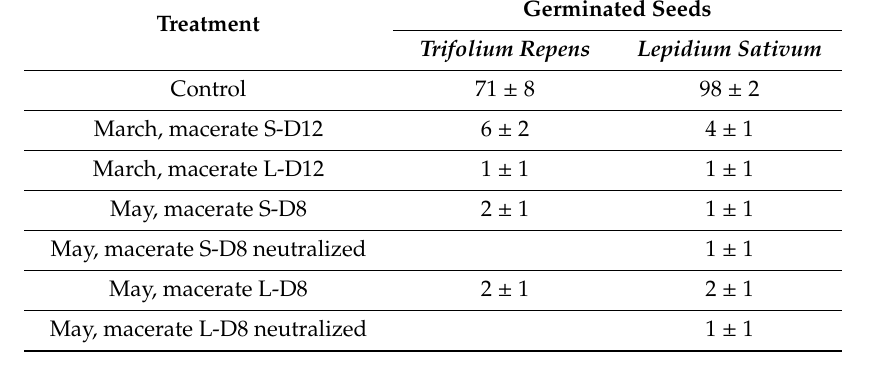
Figure 1. Germination dynamics of Trifolium repens ( left ) and Lepidium sativum ( right ) seeds in macerates prepared with leaves collected in May on trees facing north (S) or exposed to solar light (L). The germinated seeds are counted each day during the 7 days following the imbibition. Points represent mean values of four replicates (± standard error). Table 1. Number of germinated seeds for different treatments at 7 days post imbibition.